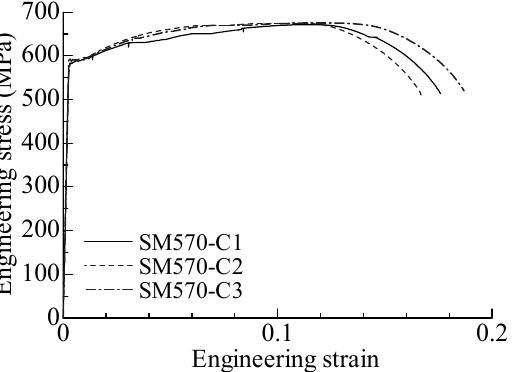
Figure 1. Specimen for testing the material properties: ( a ) Schematic diagram of the specimen; ( b ) picture of the specimen prepared using the base material (unit: mm).